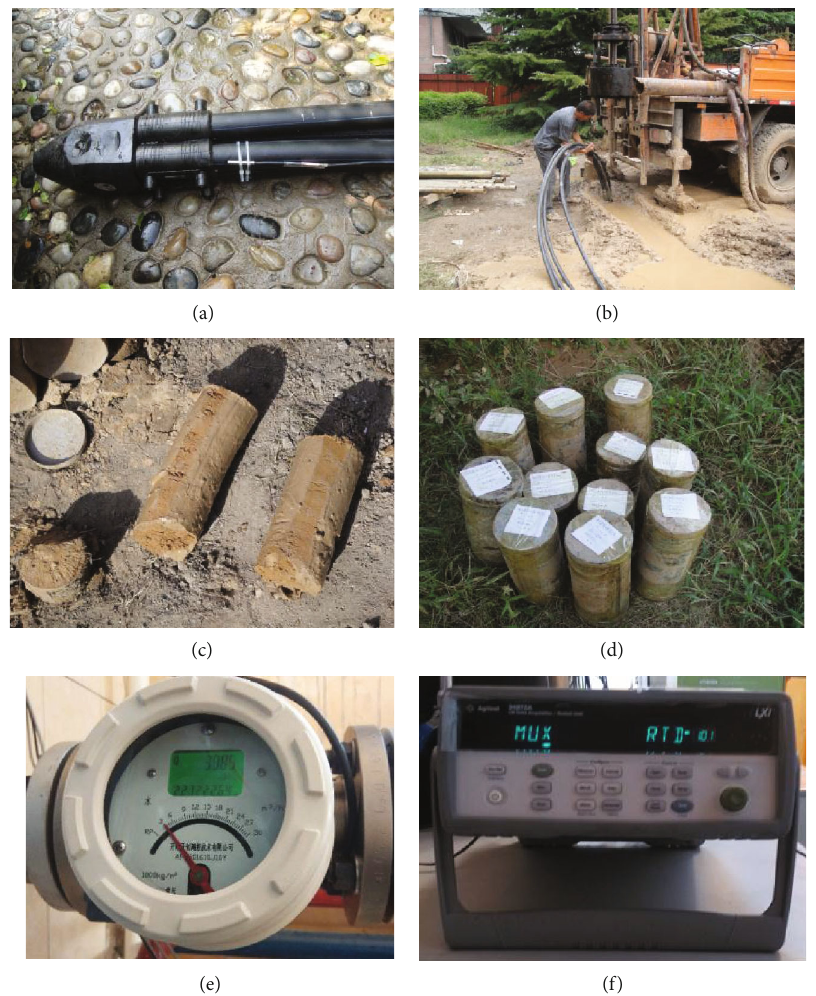
Figure 3: Digital photographs of the soil sampling